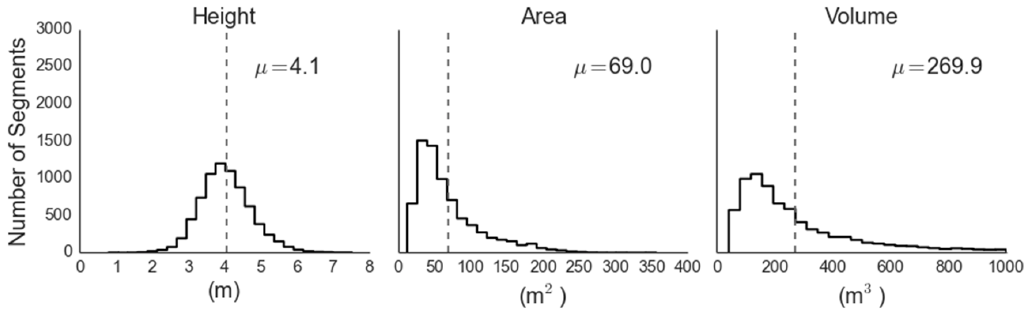
Figure 6. Distributions of juniper canopy parameters retrieved via analysis of the LiDAR data.